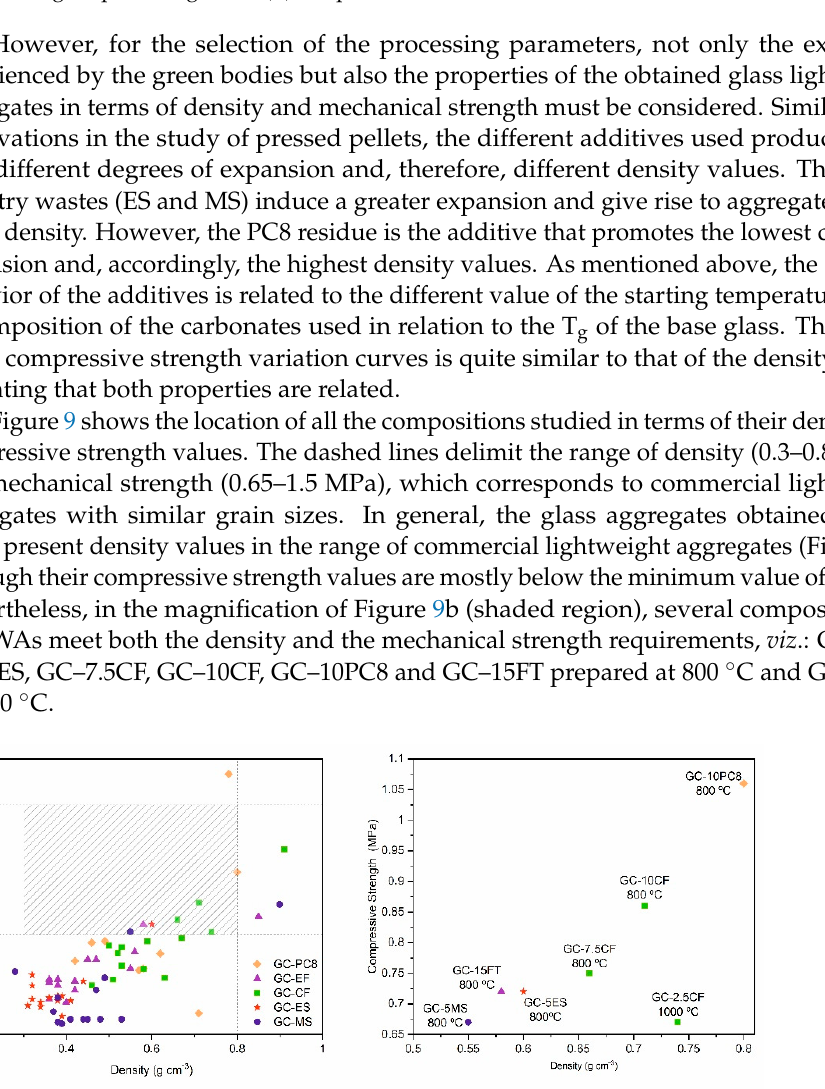
Figure 8. Evolution of linear expansion (LE) of hand–formed pellets with ( a ) temperature and expansive agent percentage, and ( b ) temperature and dwell time.